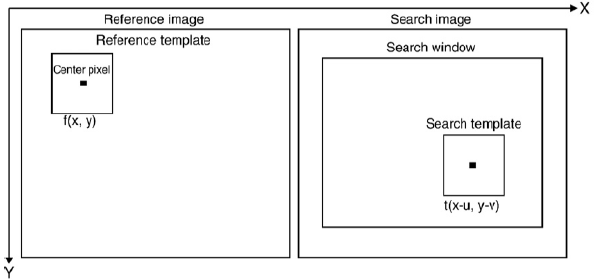
Figure 1. Normalized Cross Correlation